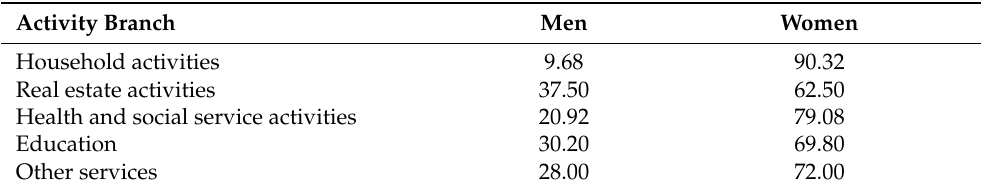
Table 2. Percentage distribution of employment by sectors in those activity branches with the highest proportion of female population.